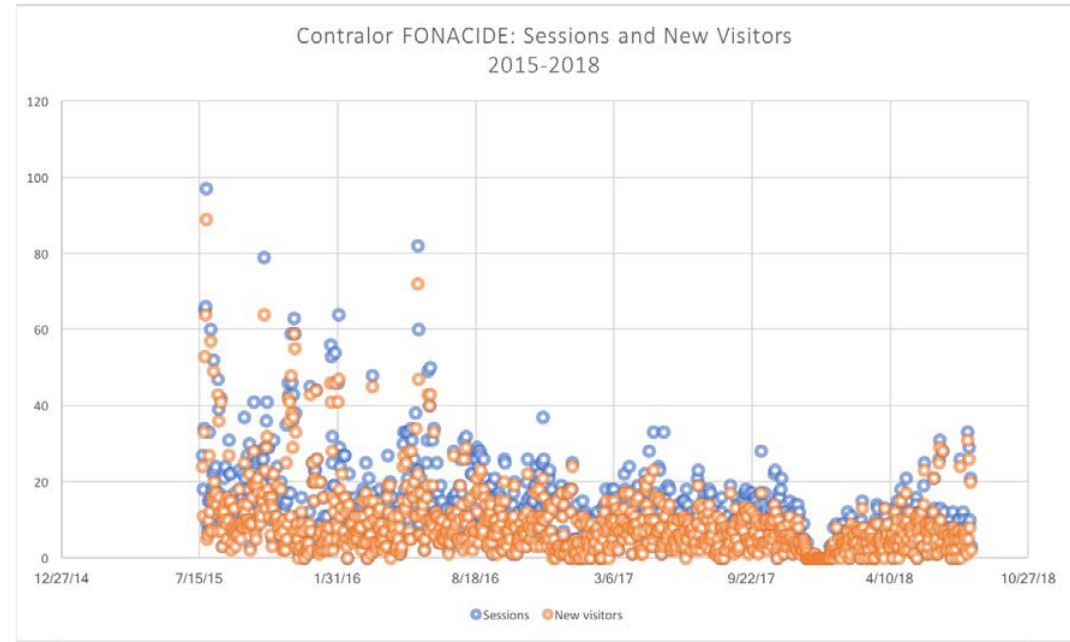
Figure 4: Contralor FONACIDE: Sessions and New Visitors